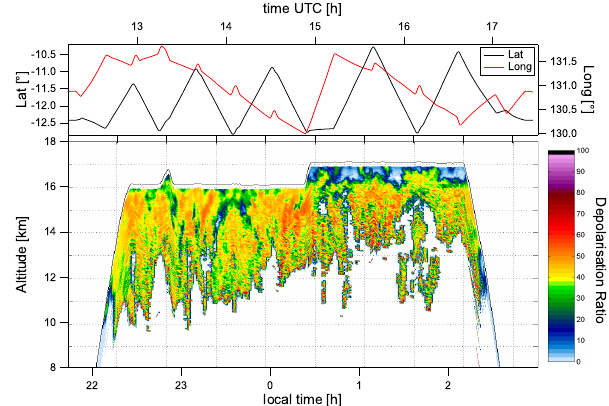
Figure 4. Volume depolarisation ratio measured by the downward looking lidar MAL during the second flight. The remnants of Hec- tor can clearly be seen. The top panel indicates the aircraft’s posi- tion (latitude and longitude). The lidar detects a surface return at all times (not shown here), thus the cloud layer thickness should be completely captured and well represented. A figure for the first flight is omitted since it is not possible to say whether the layer thickness is adequately presented at all times, due to thick clouds and the laser beam not being able to penetrate through the entire cloud vertical extent. The cloud tops, if not overshooting, were roughly located at about 17km during the first